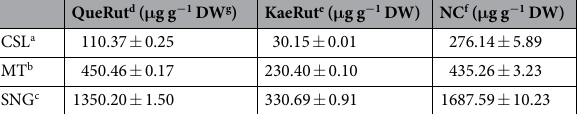
Table 1. Quantification of major flavonols in three wild-type cherry tomato variety peels. a CSL, wild-type (Csl09-03) tomato peels; b MT, wild-type (Micro Tom) tomato peels; c SNG, wild-type (Sheng Nv-Guo) tomato peels; d QueRut, quercetin rutinoside (rutin); e KaeRut, kaempferolrutinoside; f NC, naringenin chalcone; g DW, dry weight.